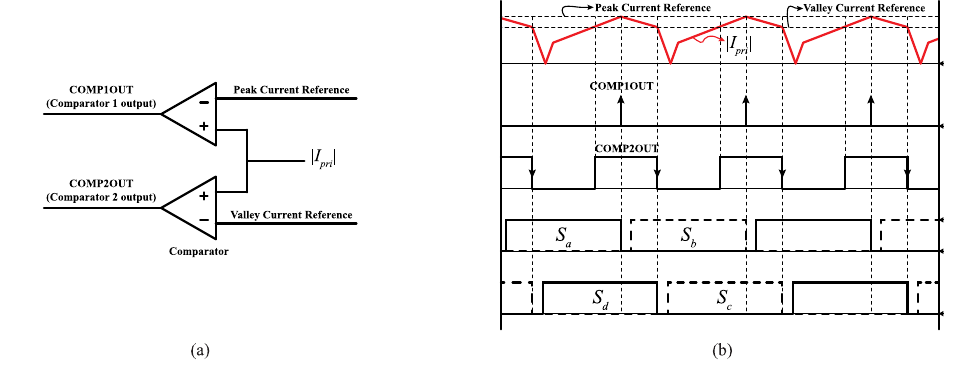
Figure 18. Hardware structure and operating principle of the digital controller; ( a ) Circuit diagram of the comparator, ( b ) Trip zone interrupt timing of the proposed HCMC.